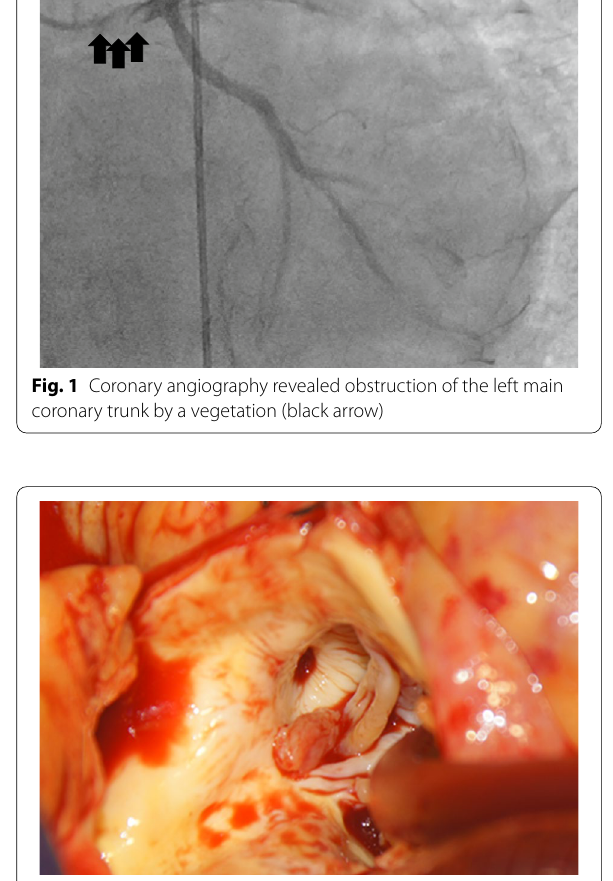
6-mm aortic vegetation was ×